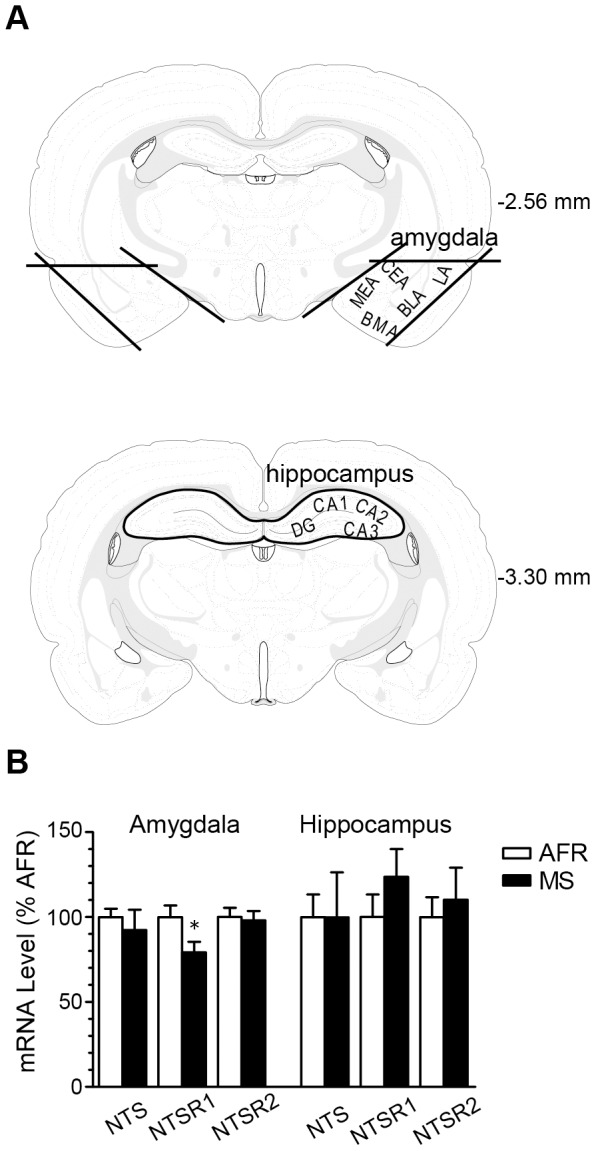
Effect of MS on the mRNA expression of neurotensin receptor 1 (NTSR1).
A, Dissected regions of the amygdala (AMY) and hippocampus (HIP) (heavy black line) in coronal sections with a thickness of 1 mm from the rat brain atlas of Paxinos and Watson [69] (2.56 and 3.30 mm posterior to bregma). B, Comparative mRNA expression levels of neurotensin, NTSR1 and NTSR2 in the AMY and HIP of MS and AFR rats. NTSR1 mRNA levels in MS rats were significantly decreased in AMY compared to AFR rats (n = 7 – 9 per group; *p<0.05, **p<0.01). Error bars represent SEM.